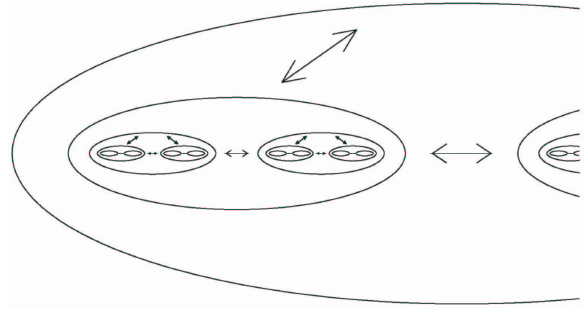
FIGURE 1. The living organism seen as a fractal structure with interacting parts on many levels. The arrows illustrate the information- transmitting interactions and are based on generalized empiric results. The figure illustrates how biologic informational systems are structured as a fractal “Chinese box”; the